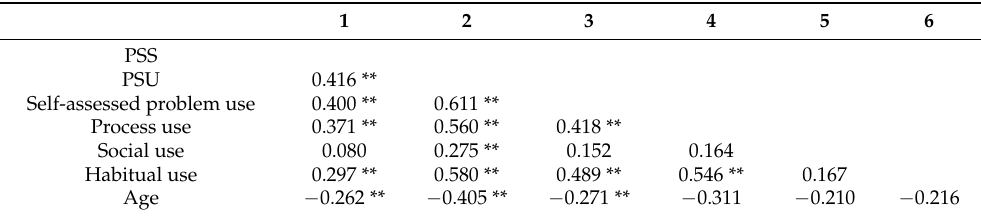
Table 2. Bivariate correlations after Pearson with MPPUS, PSS, self-assessed problem use behavior, and type of use (Social use, process use, and habitual use).